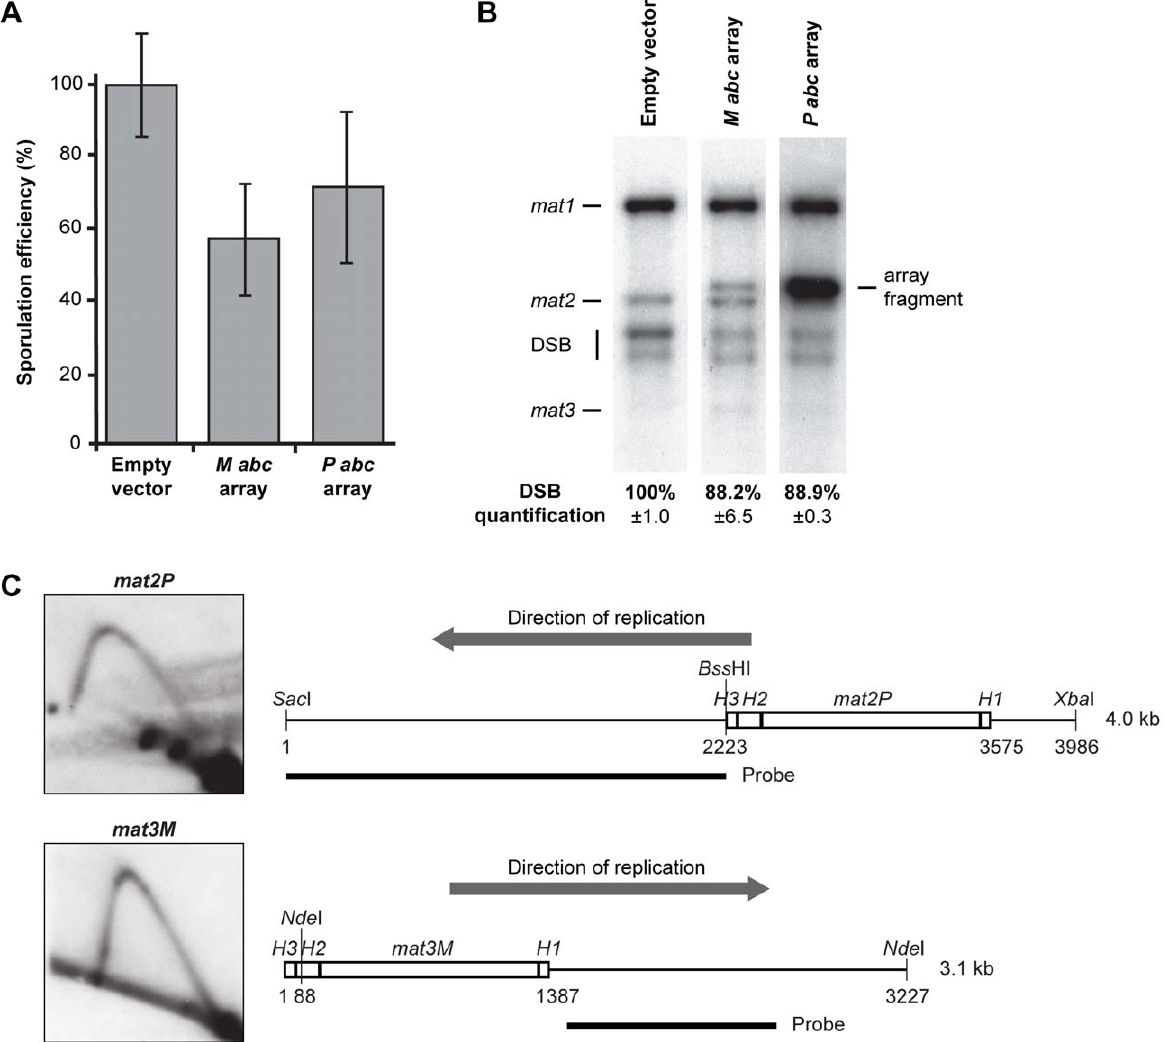
Figure 8. Out-competition of the putative trans-acting factor(s) that interacts with the Mabc and Pabc regions. (A) The effect of plasmids that carry arrays of the abc region on sporulation efficiency. Two different plasmids (constructed using pREP3X or pREP4X parental vectors) that each carries an array of approximately 10 copies of either the M abc or P abc region were introduced in the h 90 wild-type background (strain JZ1), such that two plasmid-borne arrays of either M or P abc were present. The sporulation efficiency relative to that observed for a strain carrying empty vectors (100%) are given as a graph. The deviation is shown as error bars. (B) Quantification of mat1 imprinting in strains used in panel A. Hind III fragments were run and probed with the mat1P Hind III fragment. The intensity of the signal from the P abc array is higher due to greater sequence homology. Quantification of intensities of the DSB products relative to the strain that carries the empty vectors (100%) is given below. (C) Neither P abc nor M abc induces replication pausing at the transcriptionally silenced donor loci. Left, 2D-gel analyses of mat2P and mat3M replication are shown. Right, line drawings of the fragments analyzed are given. The direction of replication through each locus is indicated with grey arrows. The positions of the restriction enzyme sites and the probes used are shown. The sizes of the fragments are